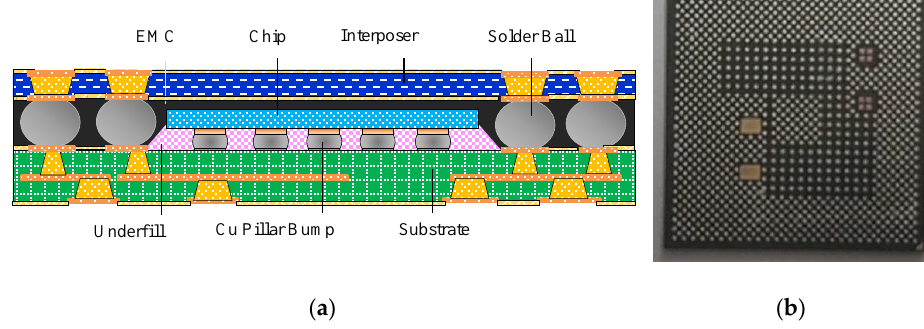
Figure 1. The FCPoP assembly: ( a ) cross-sectional view; ( b ) prototype.